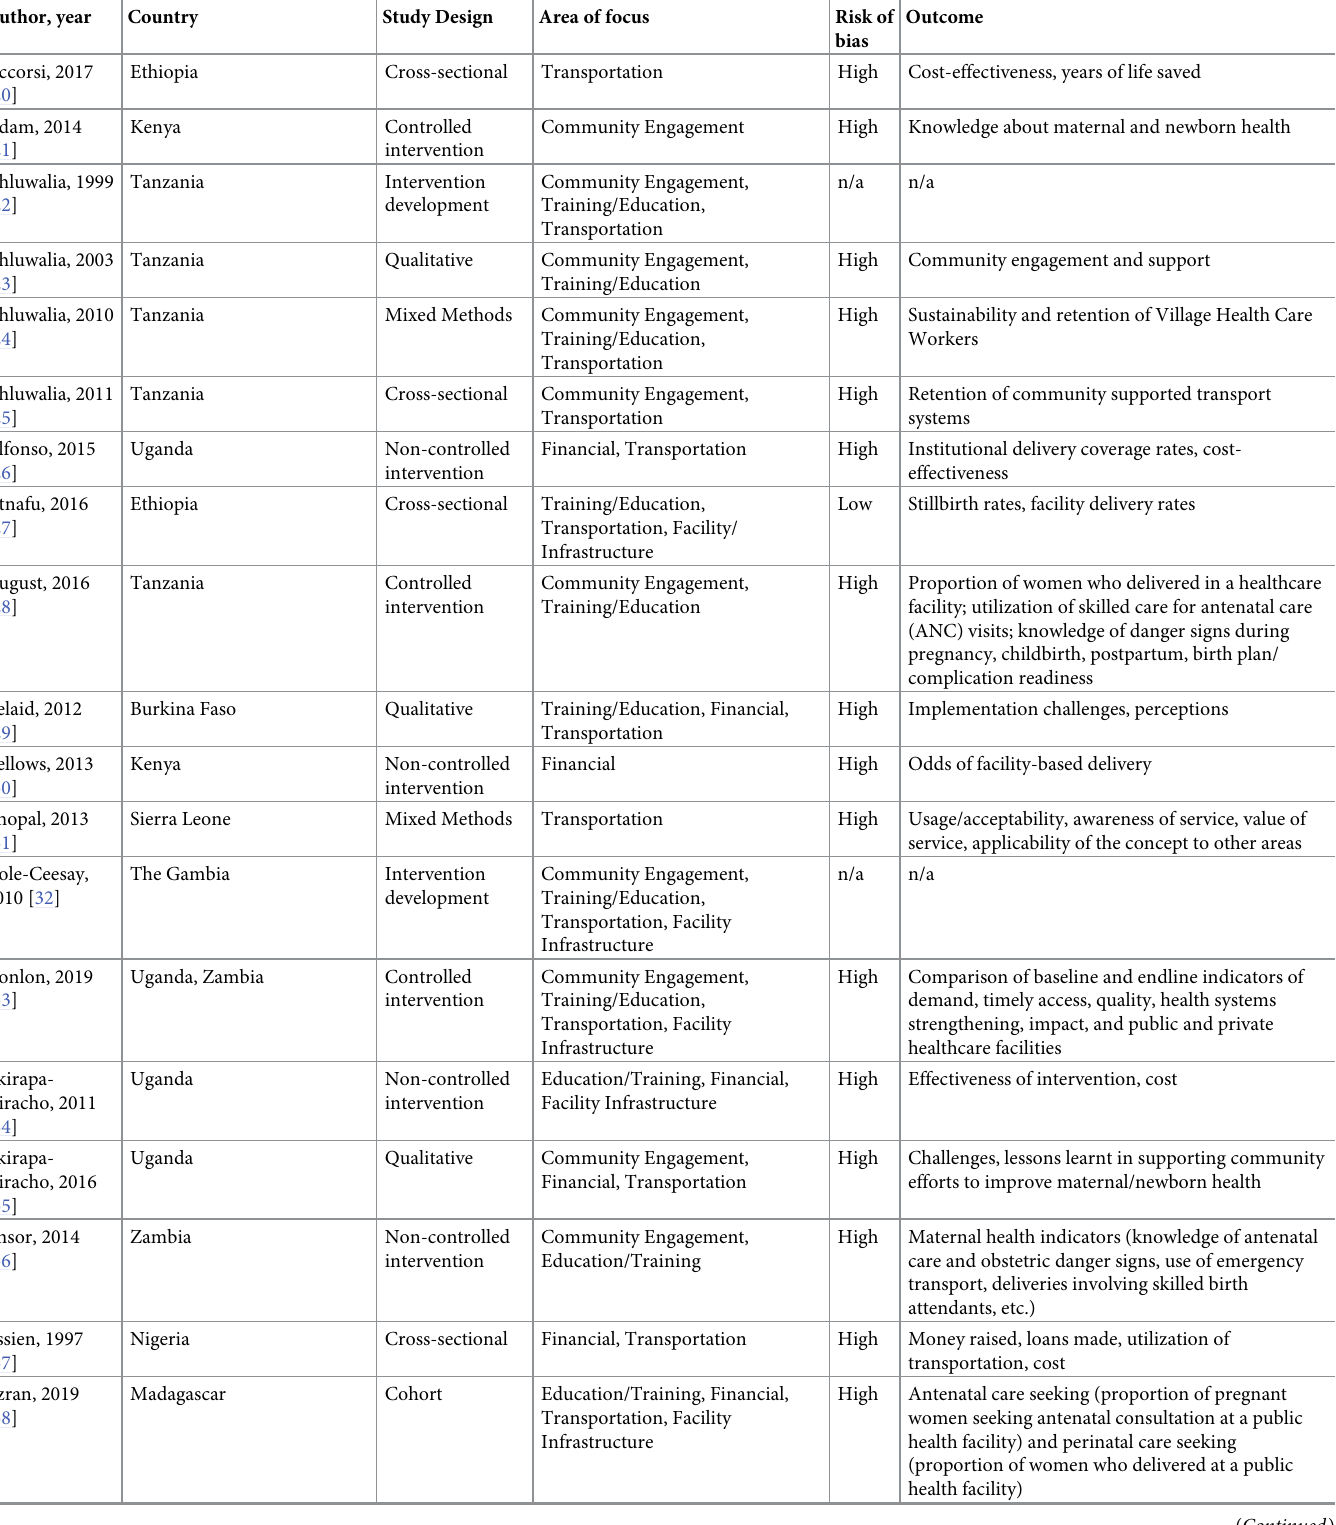
Table 1. Description of included studies by country, study design, area of focus, risk of bias and primary